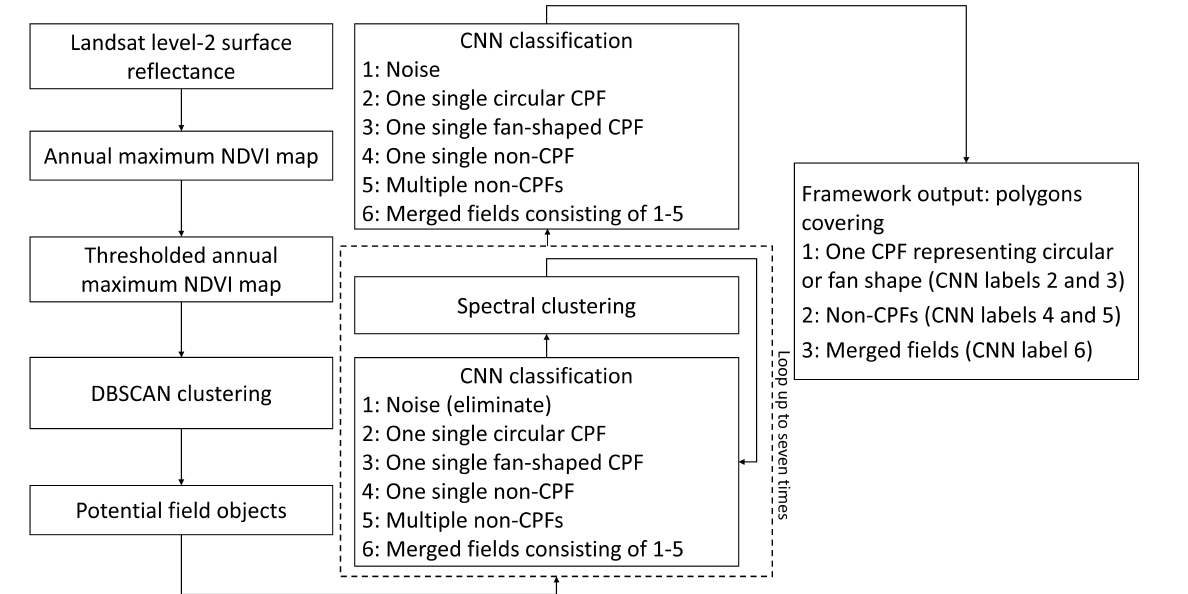
Figure 2. Flowchart showing the individual steps in the field delineation framework, including the thresholding of the annual maximum NDVI maps, DBSCAN clustering, CNN classification and spectral